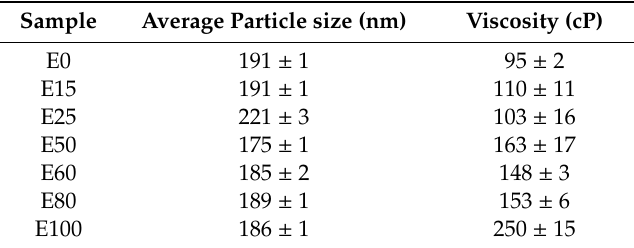
Table 2. Particle size and viscosity values of the synthesized acrylic Pressure-Sensitive Adhesives (PSAs), pH = 7.5 and 50 wt.% of solids in all cases.